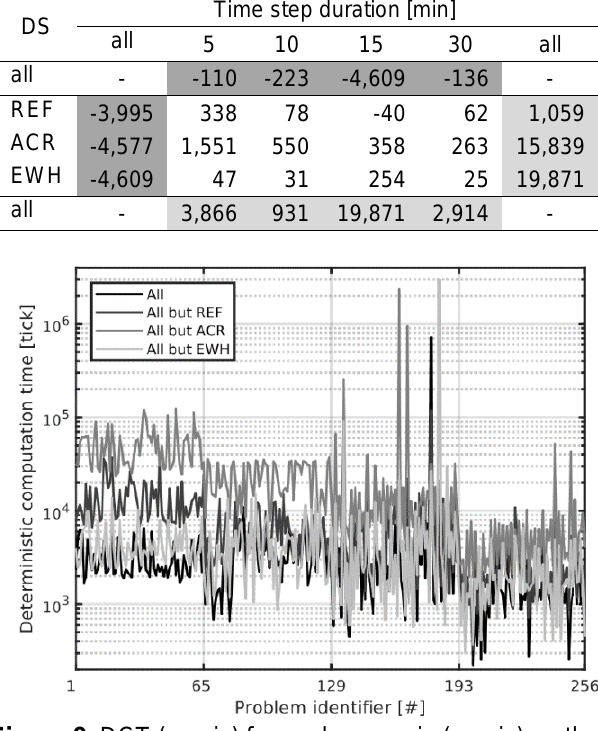
Table 4. Average, minimum (dark shade) and maximum (light shade) DCT differences due to the removal of SVs for select DSs, by DS and time step duration, as a share (%) of the average DCT for the cases with all SVs.